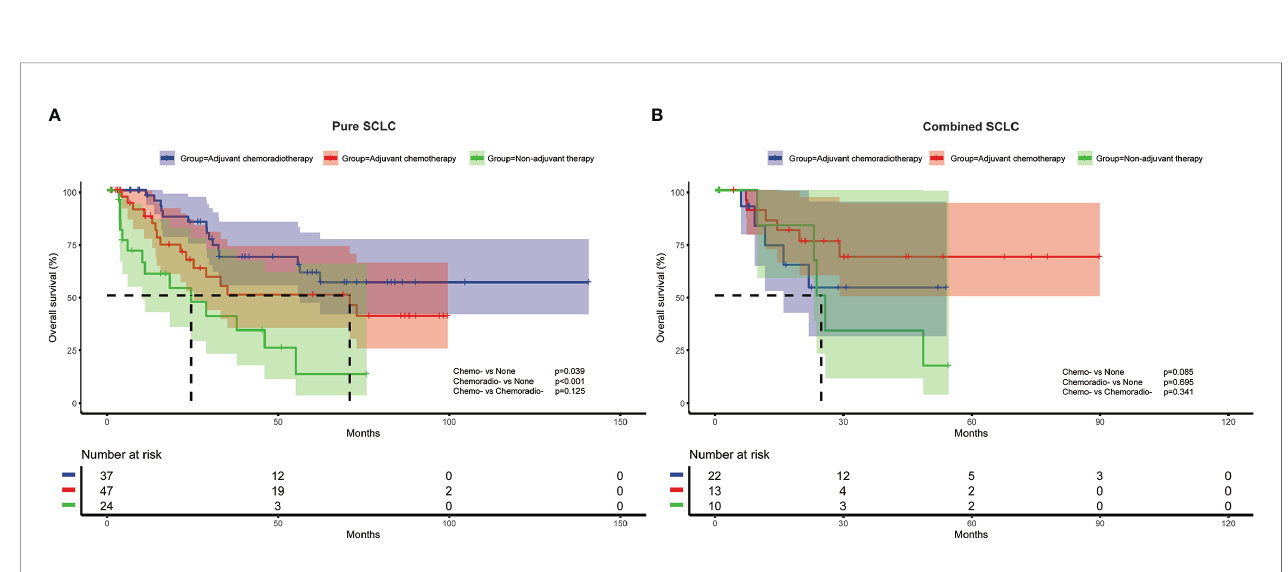
FIGURE 3 | Overall survival of different adjuvant treatment modalities in patients with pure SCLC (A) and combined SCLC (B) .